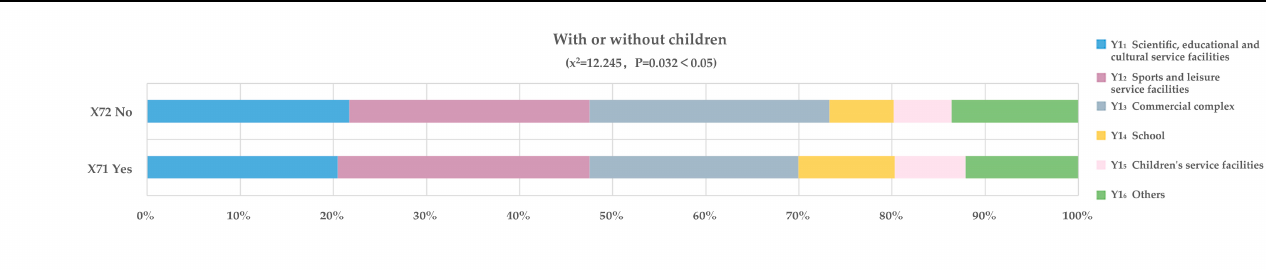
Figure 12. Demand from people with and without